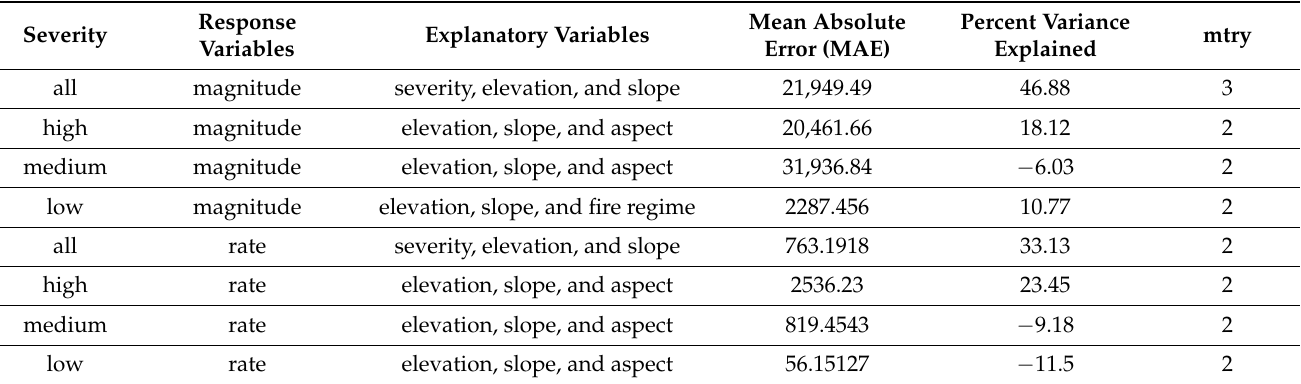
Table 6. Random forest magnitude and